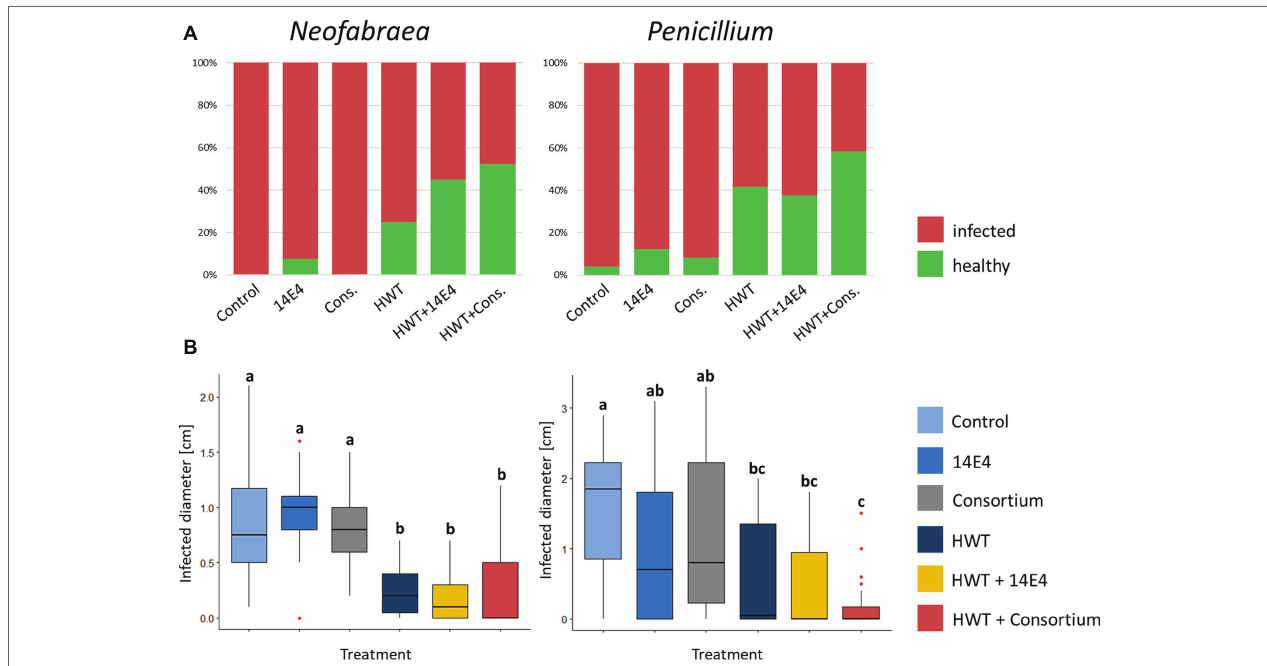
FIGURE 5 | Fraction of infected apples after storage (A) and analysis of infected diameter (B) . Apples were treated with fungal spores or conidia as well as bacterial strain P. vagans 14E4, a bacterial consortium and/or HWT. (A) Contrasts the total number of infected to healthy apples after treatment and (B) statistically evaluates the efficiency of the treatment based on the infection diameter. Statistical differences between differentially treated apple samples was assessed by Wilcoxon test (Bonferroni correction) and are indicated by lower case letters. Control samples were only inoculated with fungal spores and